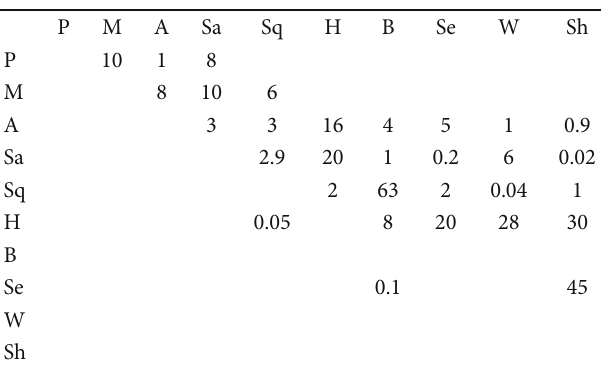
Table 1: Strategies of ten species.